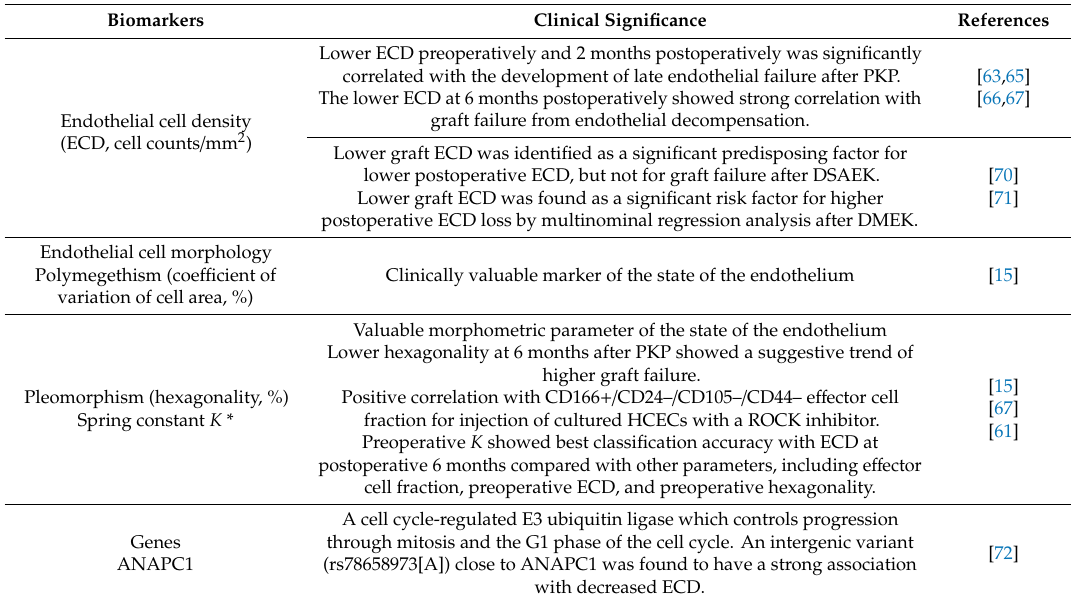
Table 2. Biomarkers for graft response related with corneal endothelial